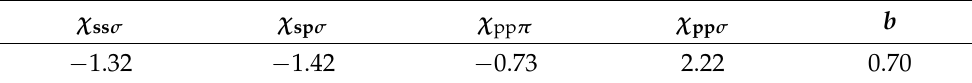
Table 2. χ values of Harrison-type expressions for nondiagonal matrix elements, utilizing Slater– Koster two-center interaction transfer integrals, and the correction factor for interactions involving H atoms, in our LCAO